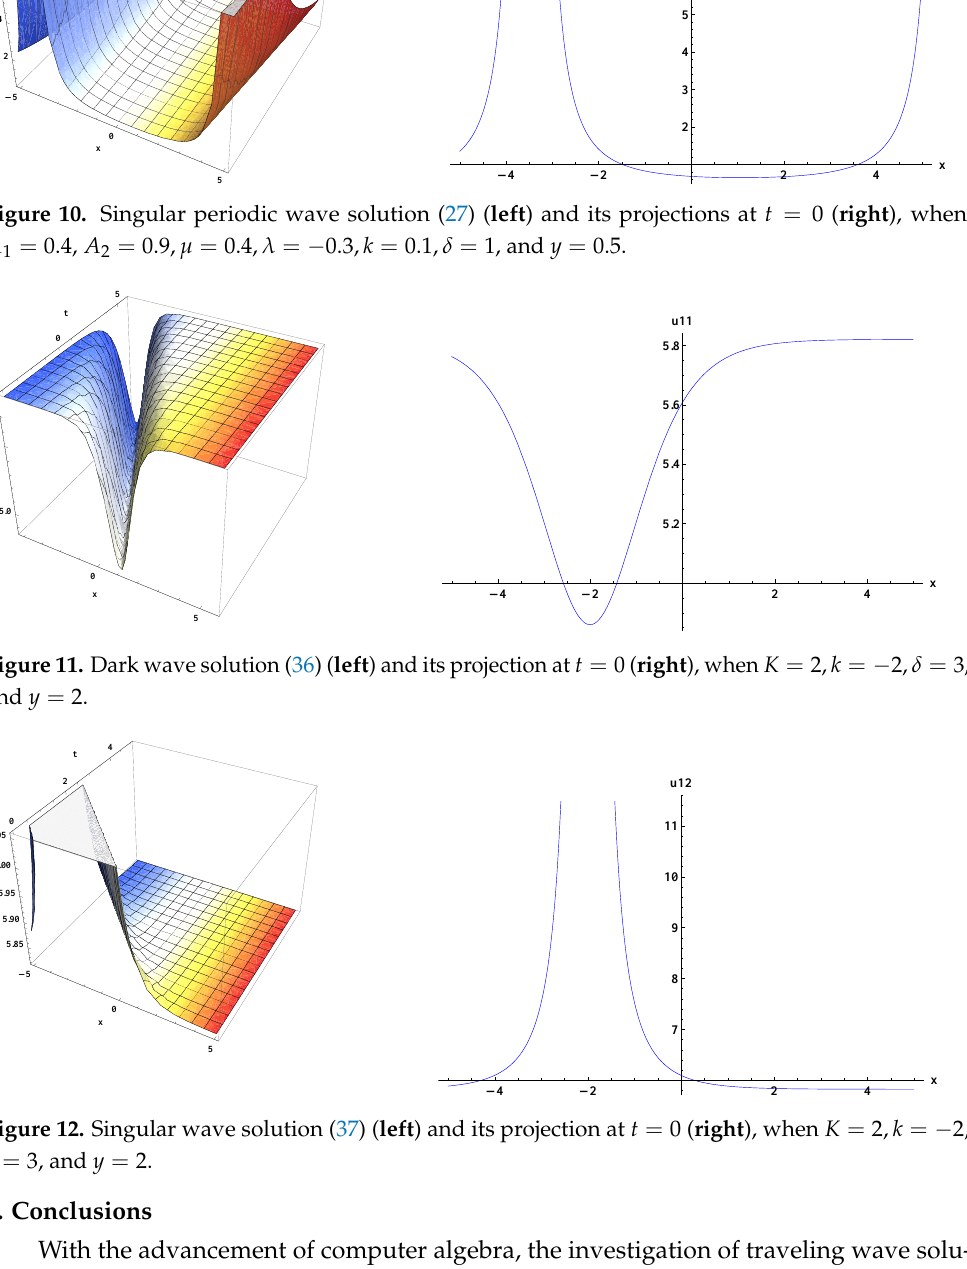
Figure 12. Singular wave solution (37) ( left ) and its projection at t = 0 ( right ), when K = 2, k = δ = 3, and y = 2.